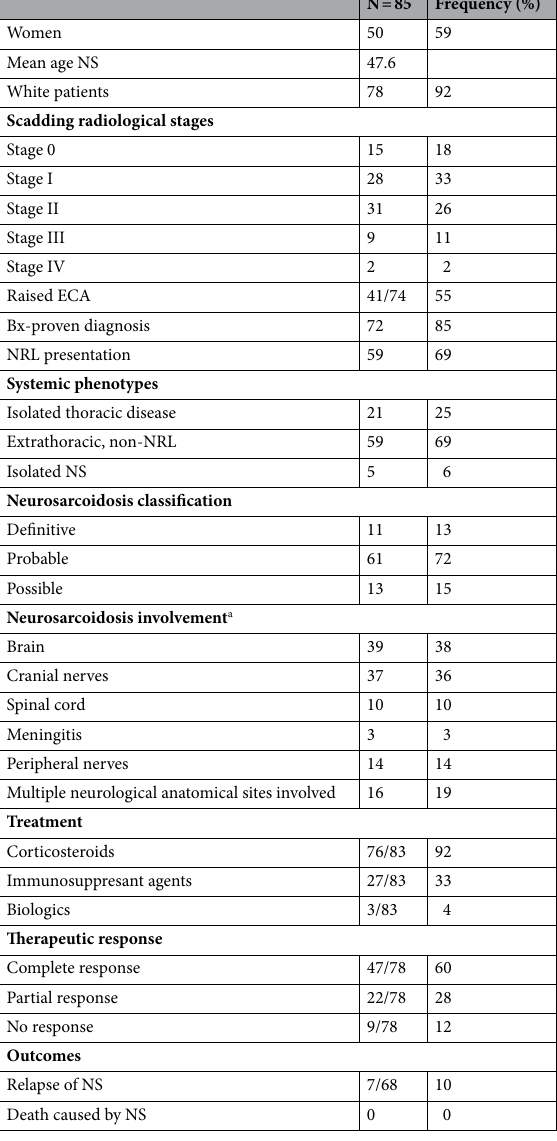
Table 1. Epidemiological profile, clinical features and outcomes of 85 patients with neurosarcoidosis defined according to the Stern criteria. a Patients may have more than one